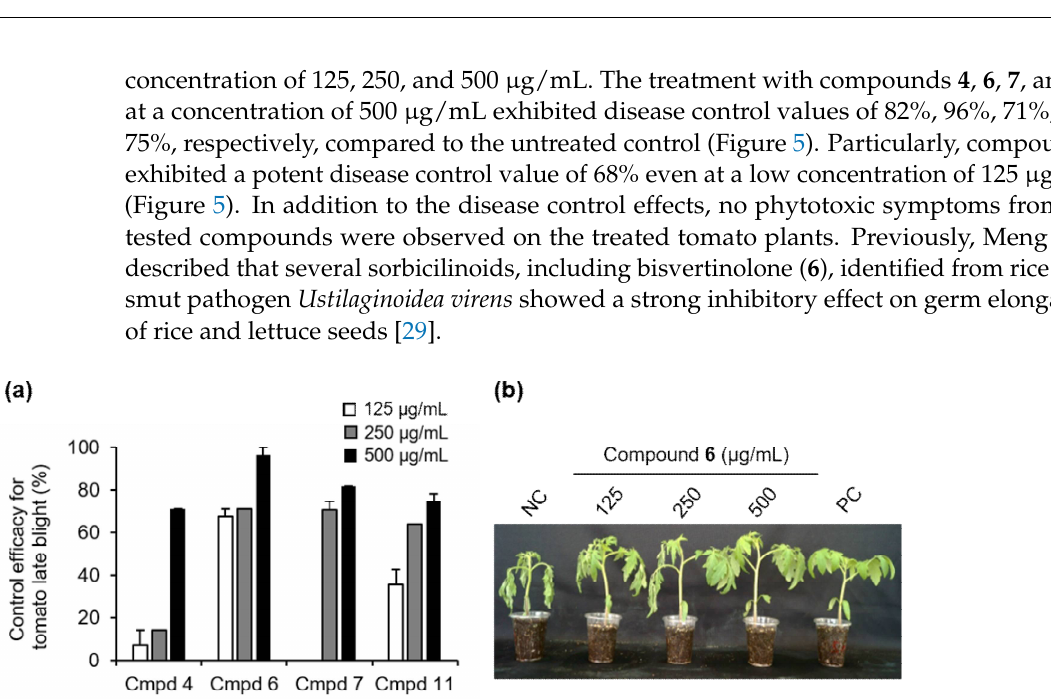
Figure 5. Effects of compounds 4 , 6 , 7 , and 11 on the development of tomato late blight. ( a ) Control efficacy of compounds 4 , 6 , 7 , and 11 against tomato late blight. The bars represent the mean ± standard deviation of two runs with three replicates. ( b ) Representatives of plants treated with compound 6 . Plants were inoculated with a spore suspension of Phytophthora infestans 1 day after treatment with compound 6 . NC, treatment with the 0.025% Tween 20 solution containing 5% MeOH was used as a negative control; PC, a chemical fungicide dimethomorph (10 µg/mL) was used as a positive control.